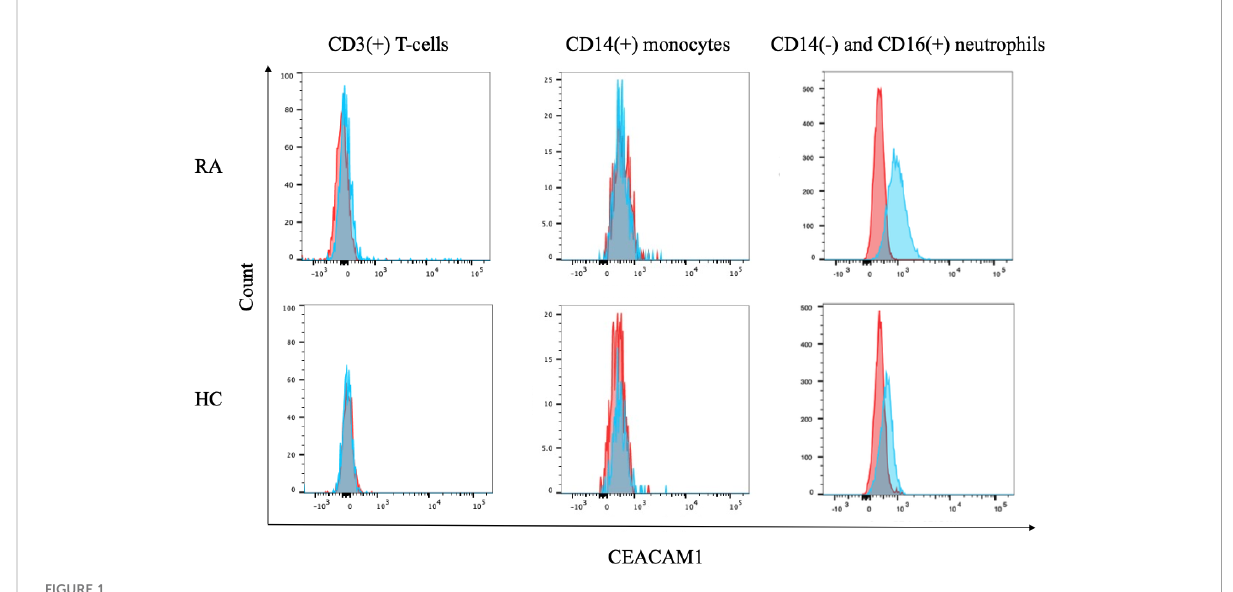
FIGURE 1 The expression of CEACAM1 on peripheral blood immune cells. Flow cytometry overlay histograms for CEACAM1 demonstrating typical cell pro fi les from subdivided peripheral blood immune cells from RA patients and HC. CEACAM1 expression was detected using anti – CEACAM1 antibody (blue shaded histogram) or isotype control antibody (red shaded histograms). In contrast to lymphocytes or monocytes, peripheral blood neutrophils expressed CEACAM1 on their surface. RA, rheumatoid arthritis; HC, healthy controls.